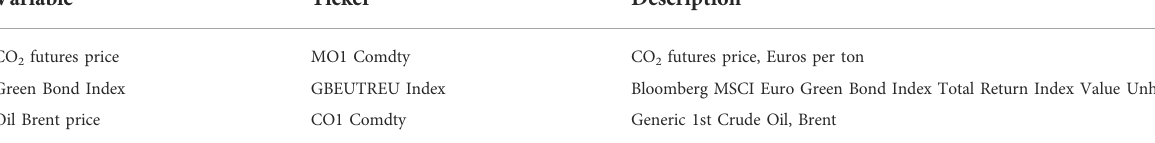
TABLE 1 List of variables.